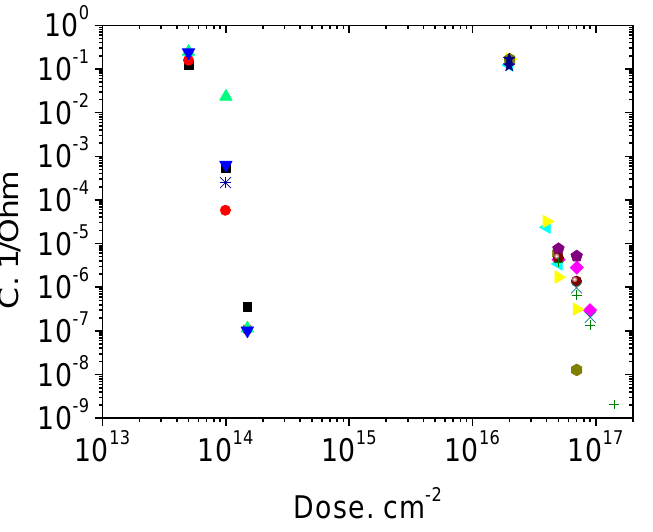
Figure 5. Base conductivity of a Schottky diode (600 V) after (1) electron and (2) proton irradiation. Different symbols correspond to different diodes from the same batch.